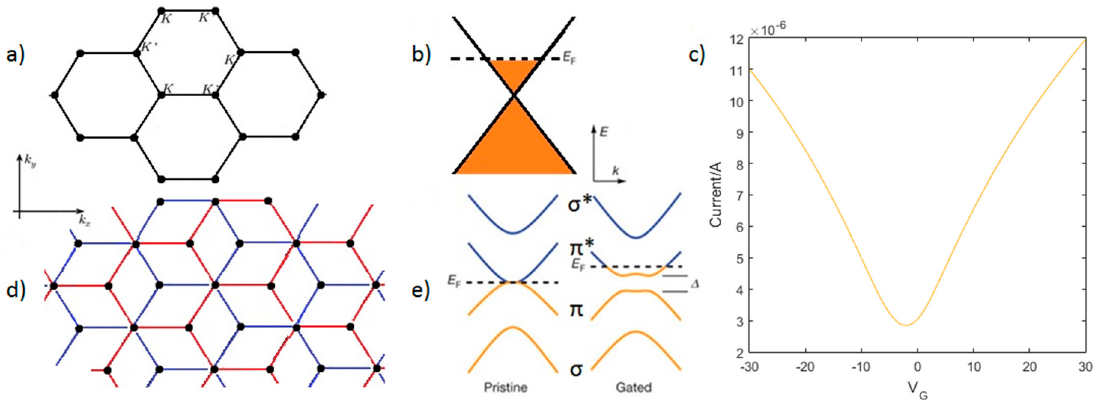
Figure 1. Showing ( a ) the honeycomb structure of single layer graphene with the K and K’ points in the first Brillouin Zone (reproduced by permission of Cambridge University Press, subject to cambridge.org/uk/information/rights/permission.htm); ( b ) the linear energy-wavenumber relationship close to the Dirac point with a Fermi level that we can change through the application of a electric field; ( c ) the drain-source current of graphene against gate voltage [74] with a sample dependent Dirac point and electron and hole mobilities; ( d ) the structure of AB stacked bilayer graphene, with the two layers marked in red and blue respectively and a hopping parameter of ~0.4 eV between the layers; and ( e ) the band structure for bilayer graphene showing pristine bilayer graphene and the opening of a band gap for gated bilayer graphene with AB stacking (reproduced with permission of Nature Publishing Group) [75]. In the gated we see “trigonality” at very low energies [16].